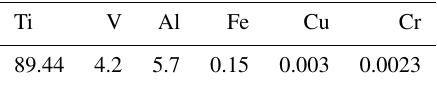
Table 2. Composition (wt%) of Ti-6Al-4V alloy used in experi- ments.